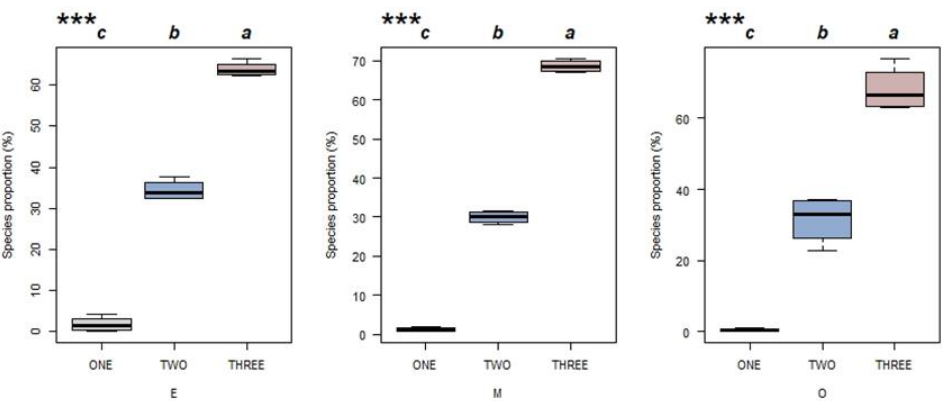
Figure 5. The proportion of species in Hainan tropical lowland rainforest stands belonging to each of three ecological strategies groups for multiple successional stages (E = early succession, M = mid-succession and O = late succession). Primary strategies (in grey) include C and S. Secondary strategies (in blue) include CS, CR and CSR. Tertiary strategies (in red) include C/CR, C/CS, C/CSR, CR/CSR, CS/CSR, R/CR, R/CSR, S/CS, S/CSR, S/SR and SR/CSR. *** p < 0.01 in a one-way ANOVA ( n = 4). Different letters indicate significant differences between ecological strategies groups (Tukey’s test; p < 0.05).